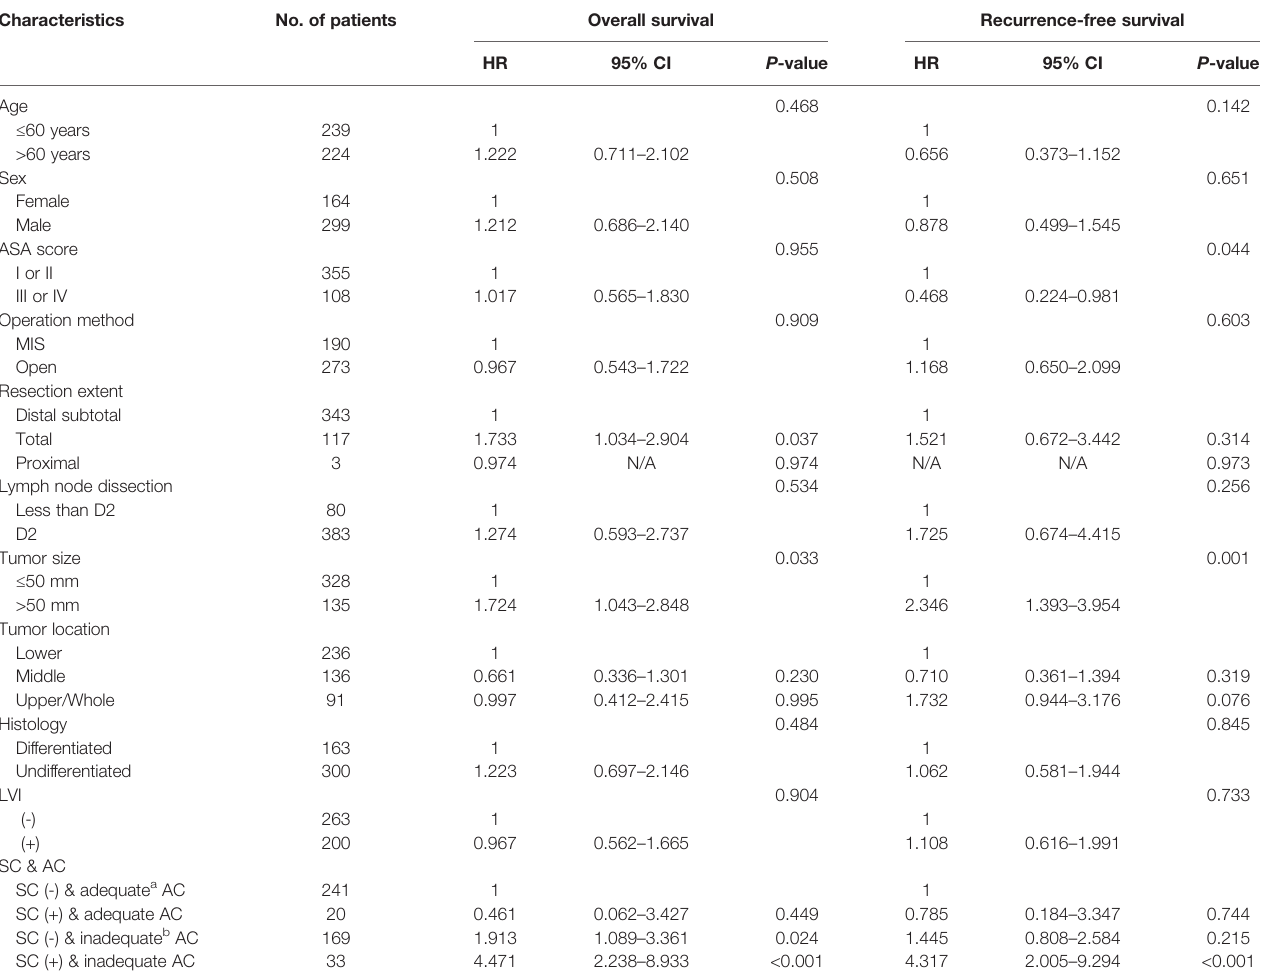
TABLE 4 | Multivariate analyses of overall and recurrence-free survival in stage II gastric cancer patients.